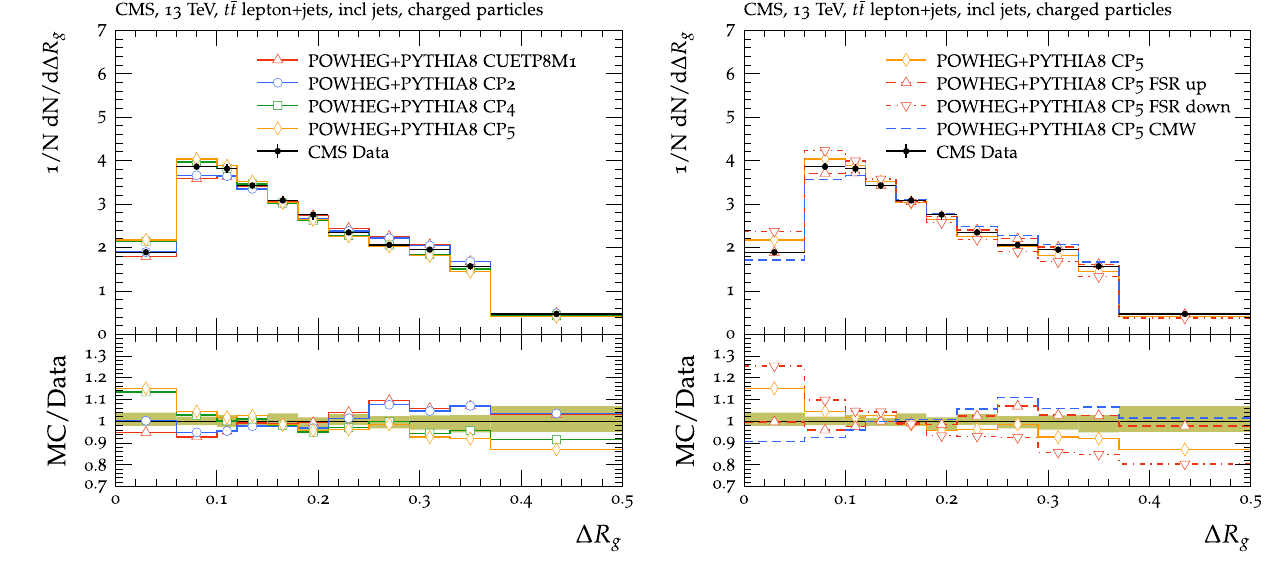
and CP5 with CMW rescaling (right). The ratios of simulations to the data (MC/Data) are also shown, where the shaded band indicates the total experimental uncertainty in data. Vertical lines drawn on the data points refer to the total uncertainty in the data. Horizontal bars indicate the associated bin